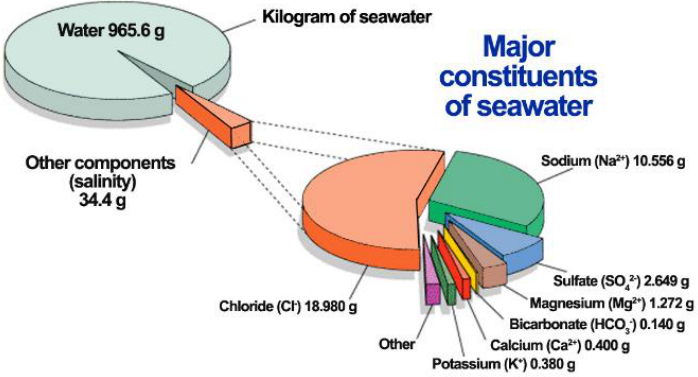
Figure 12. Graphic example of 1 kg of seawater composition [28].